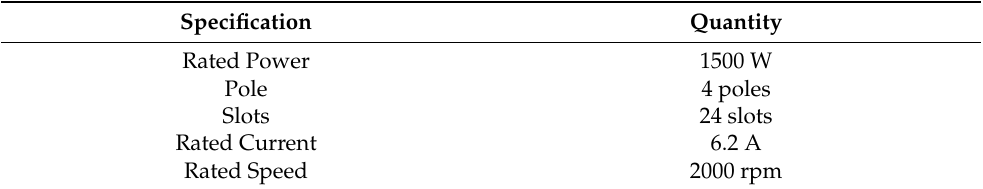
Table 1. PMSM Specification.